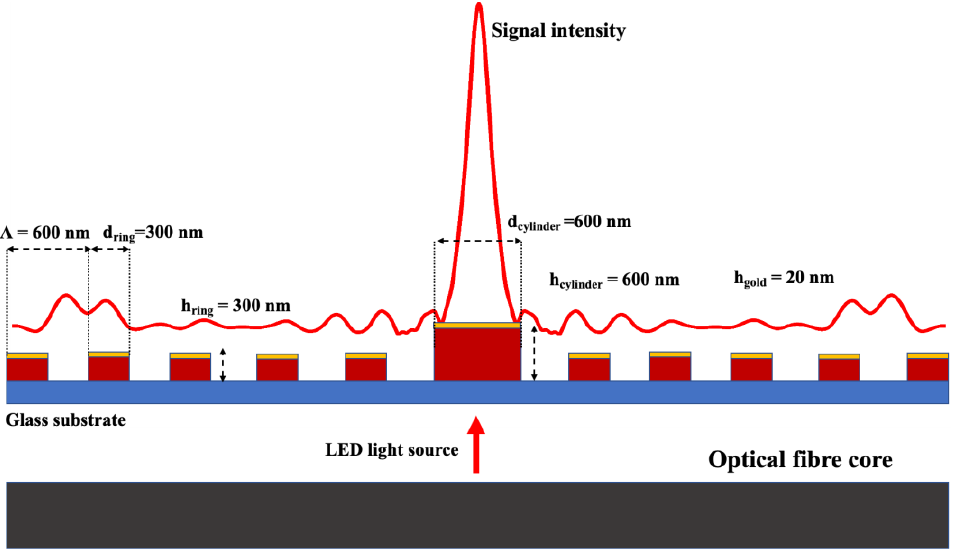
Figure 2. Cross-section of MRZ structure consisting of series of six equidistant IP-Dip rings (red) with a 20 nm thin Au layer deposited on top of the structure (yellow) fabricated on a glass substrate (blue) and its simulated optical field.